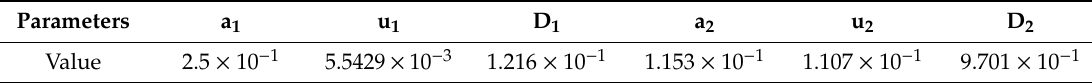
Table 2. Parameters of the material property for the